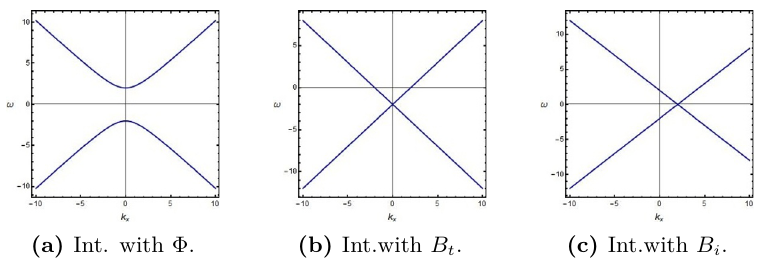
Figure 4. SF for one flavor. (a) scalar Interaction generate a gap. (b) B t shift the spectrum along ω direction. B t = 2 (c) B i shift the spectral cone in k i direction. B i = 2